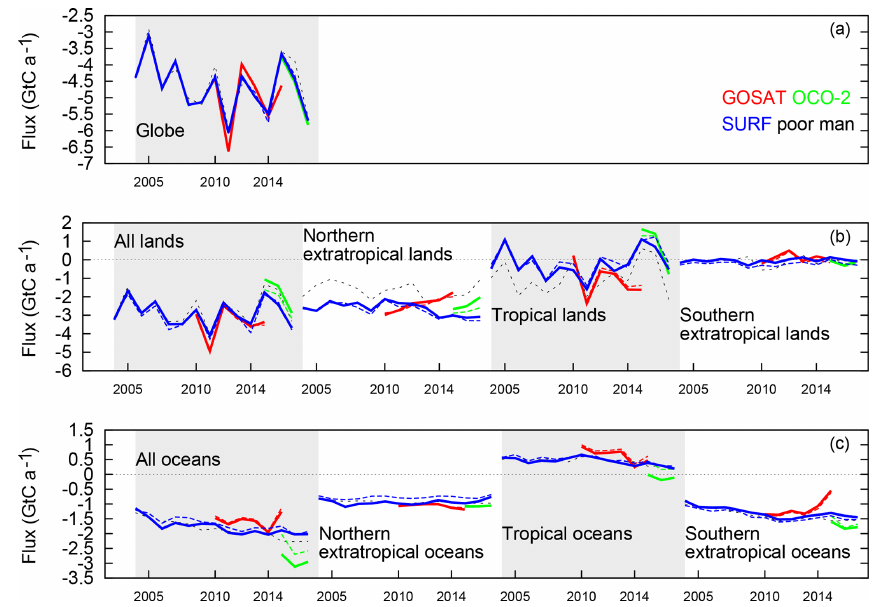
Figure 2. Time series of inferred natural CO 2 annual flux (without the prescribed fossil fuel emissions) between 2004 and 2017, averaged over the globe or over all lands or oceans. In the case of lands and oceans three broad latitude bands are also defined: northern extratropics (north of 25 ◦ N), tropics (within 25 ◦ of the Equator), and southern extratropics (south of 25 ◦ S). Inversions with LMDz5A (LMDz6A) are shown using continuous (dashed) coloured lines. In the sign convention, positive fluxes correspond to a net carbon source into the atmosphere. The last year of the GOSAT inversions (2016) is not represented because it is less constrained at the end by the lack of 2017 retrievals here. Note that the prior fluxes are zero over land at this temporal scale (see Sect. 2.2) and that they are equal to the “poor man” curve over the ocean (see Sect. 2.5).